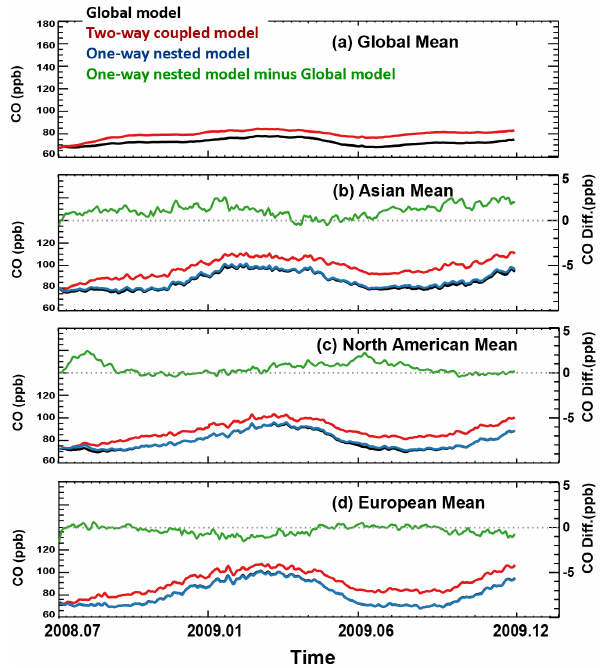
Figure 5. Daily mean tropospheric mean CO mixing ratio from July 2008 to December 2009 averaged over the global or nested model domains simulated by the global model alone (black), by the two- way coupled model (red), and by the one-way nested model (blue; with no feedbacks to the global model; only for nested domains). Also shown in (b–d) is the difference between the one-way nested and the global model (green; right